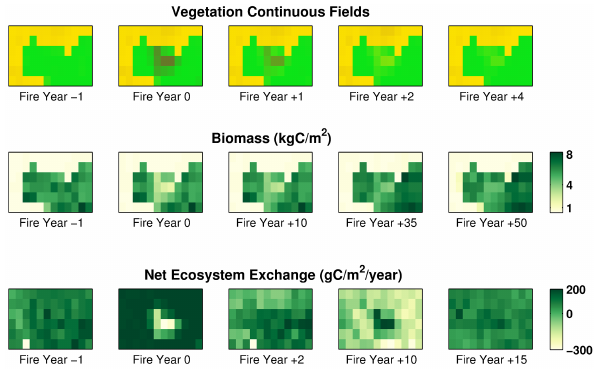
Figure 5. Post-fire evolution of the carbon stocks and fluxes af- ter the fire disturbance indicated in Fig. 4 (centre). Top: vegetation cover in Vegetation Continuous Fields format (Green = Trees, Yel- low = Grass, Brown = Bare Ground); middle: biomass density in kg of carbon m − 2 ; bottom: Net Ecosystem Exchange in g of carbon m − 2 year − 1